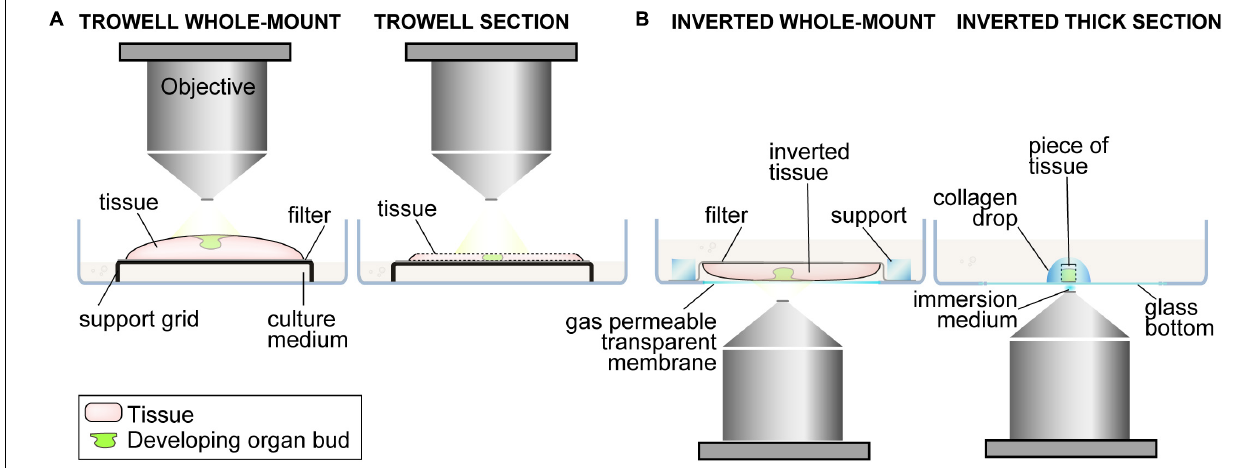
FIGURE 3 | Culturing methods for live tissue whole mount imaging. A schematic representation of culturing setups that have been used for ectodermal live tissue whole mount imaging. (A) In the Trowell-type whole-mount setup the tissue, such as the whole embryonic mandible or back skin, is maintained in the interface of air and culturing medium on a filter supported by a grid. The tissue is oriented with the epithelium side upward. This culturing setup allows free gas exchange and maintains the physiologically intact tissue environment. Imaging is done with a upright microscope setup with an air interface objective in an environment controlled chamber. This imaging and culturing setup can also be used with thick tissue sections that are useful especially in later developmental stages when the tissue becomes thicker and/or less transparent and it gives high resolution information in the cross-sectional z -axis. (B) Tissues can also be cultured for imaging submerged in the culture medium. In this setup the whole-mount tissue is mechanically fixed in place with the epithelium side facing the bottom of the culture dish. The gas exchange and imaging with a inverted microscope setup takes place through a gas permeable optically transparent membrane in the bottom of the dish. The developing organ bud can also be dissected out of the tissue and maintained and imaged